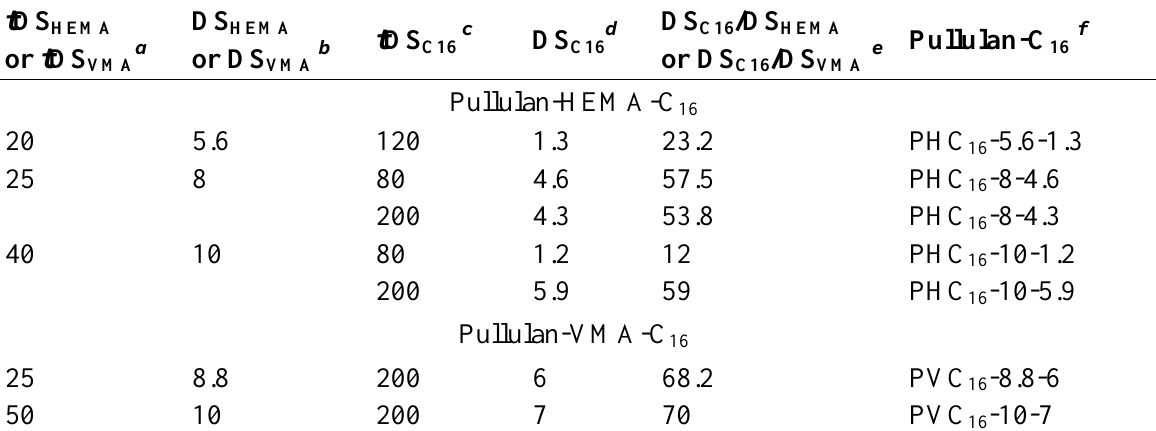
Table 1. Characteristics of Pullulan-C